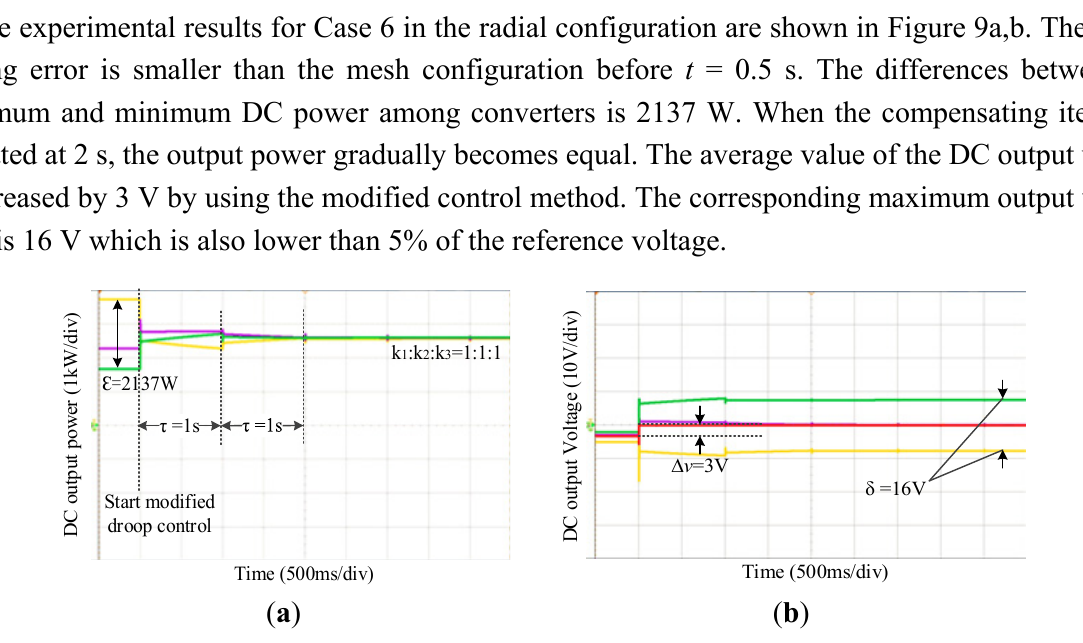
Figure 9. Modified control method test result for Case 6 in radial configuration. ( a ) Power sharing accuracy; ( b ) Voltage